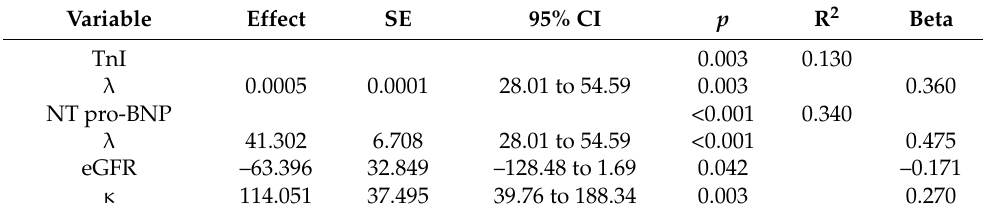
Table 8. Multivariable linear regression model of TnI and NT pro-BNP concentrations in the group with involvement of the myocardium by amyloids formed from monoclonal λ